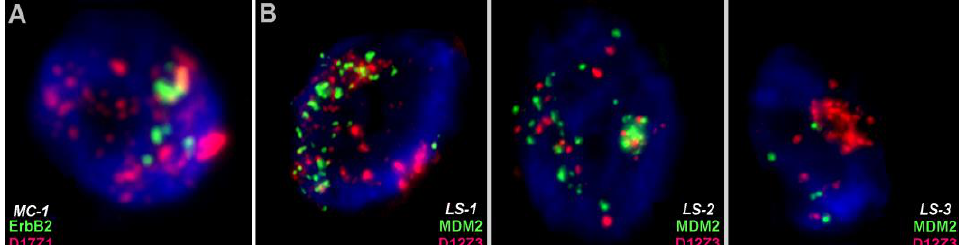
Figure 3. Two color fluorescence in situ hybridization (FISH) results on formalin-fixed paraffin-embedded nuclei derived from ( A ) mammary carcinoma (MC-1) or ( B ) liposarcoma (LS) cases 1 to 3 are presented. In ( A ) ~6 ErbB2 signals (green) with >30 signals of D17Z1 (red — amplification). In ( B ) cases, LS-1 and LS-2 appear to demonstrate a homogeneously staining region, each including between ~10 and ~15 MDM2 (green) and D12Z3 copies (red) each. Case L-3 has an amplification of D12Z3 signals and only 4 MDM2 signals.